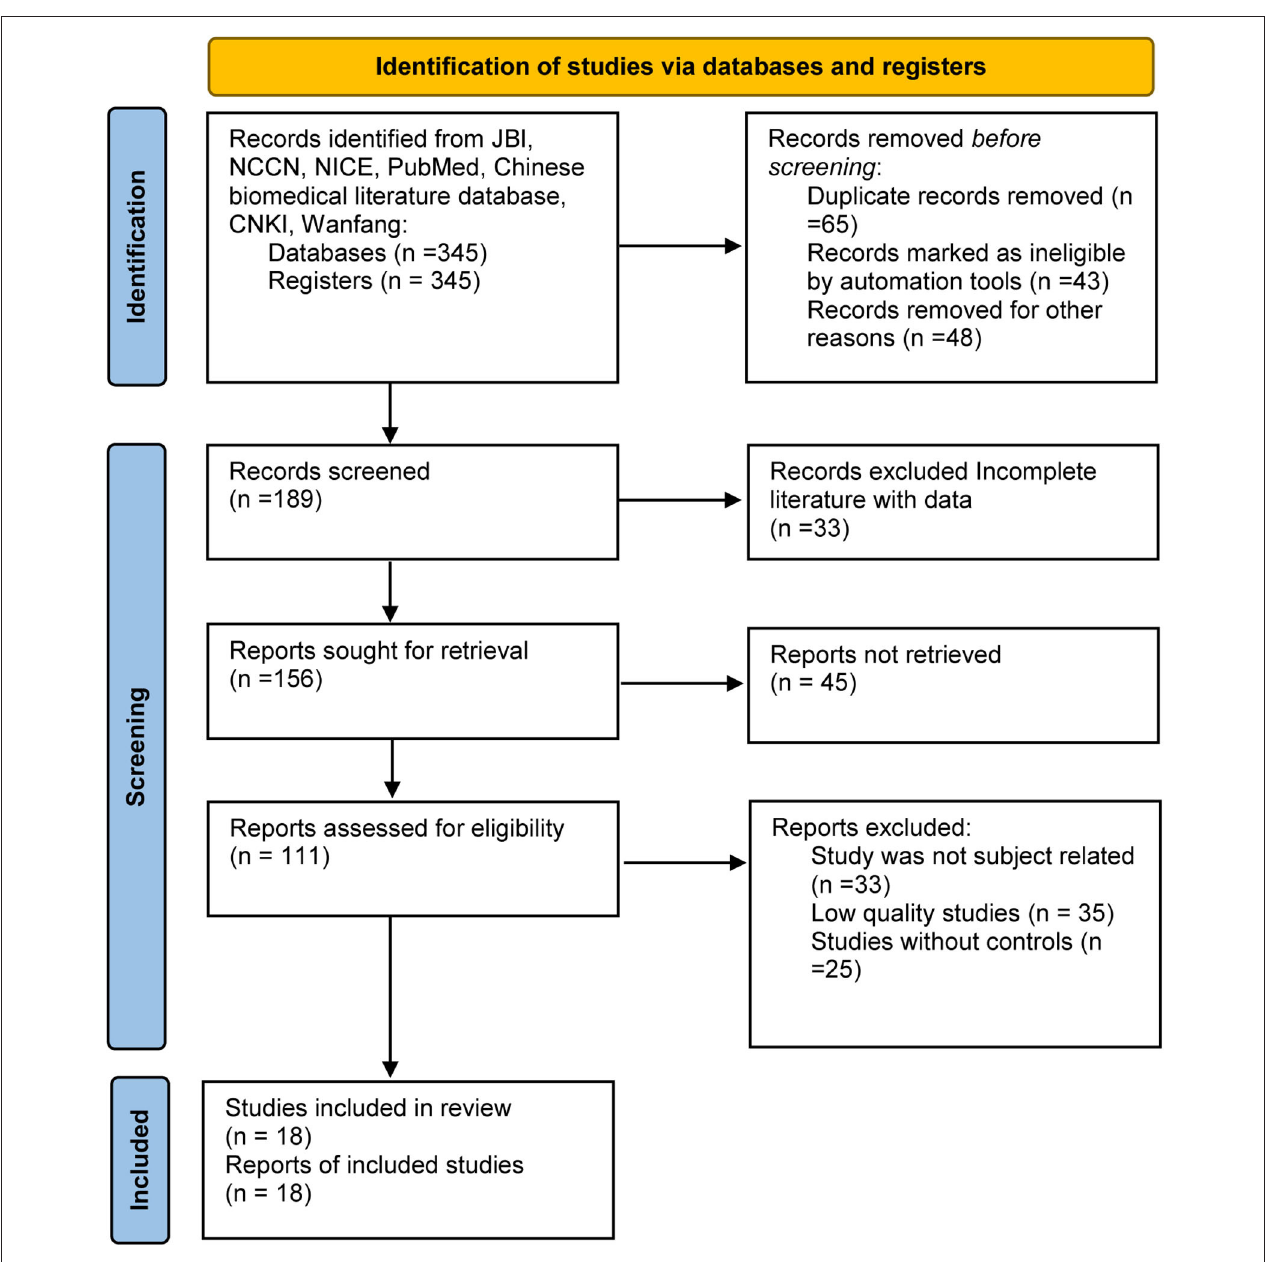
FIGURE 1 | PRISMA flow diagram for the meta-analysis.